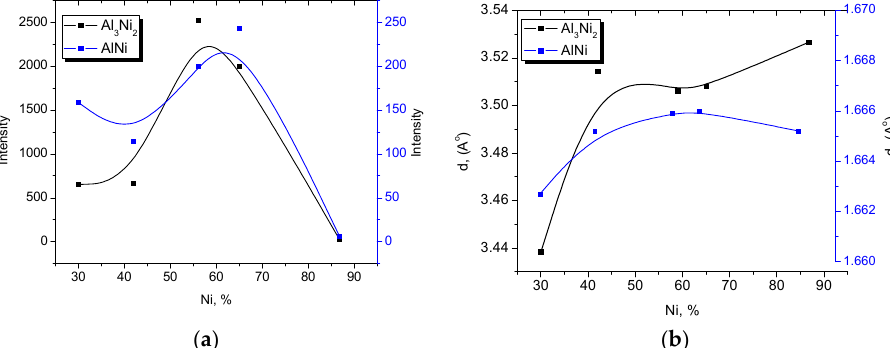
Figure 3. Influence of Ni concentration in the powder mixture (coating after two gun passes) on the yield of NiAl and Ni 2 Al 3 ( a ) and on their crystal lattice parameters ( b ).